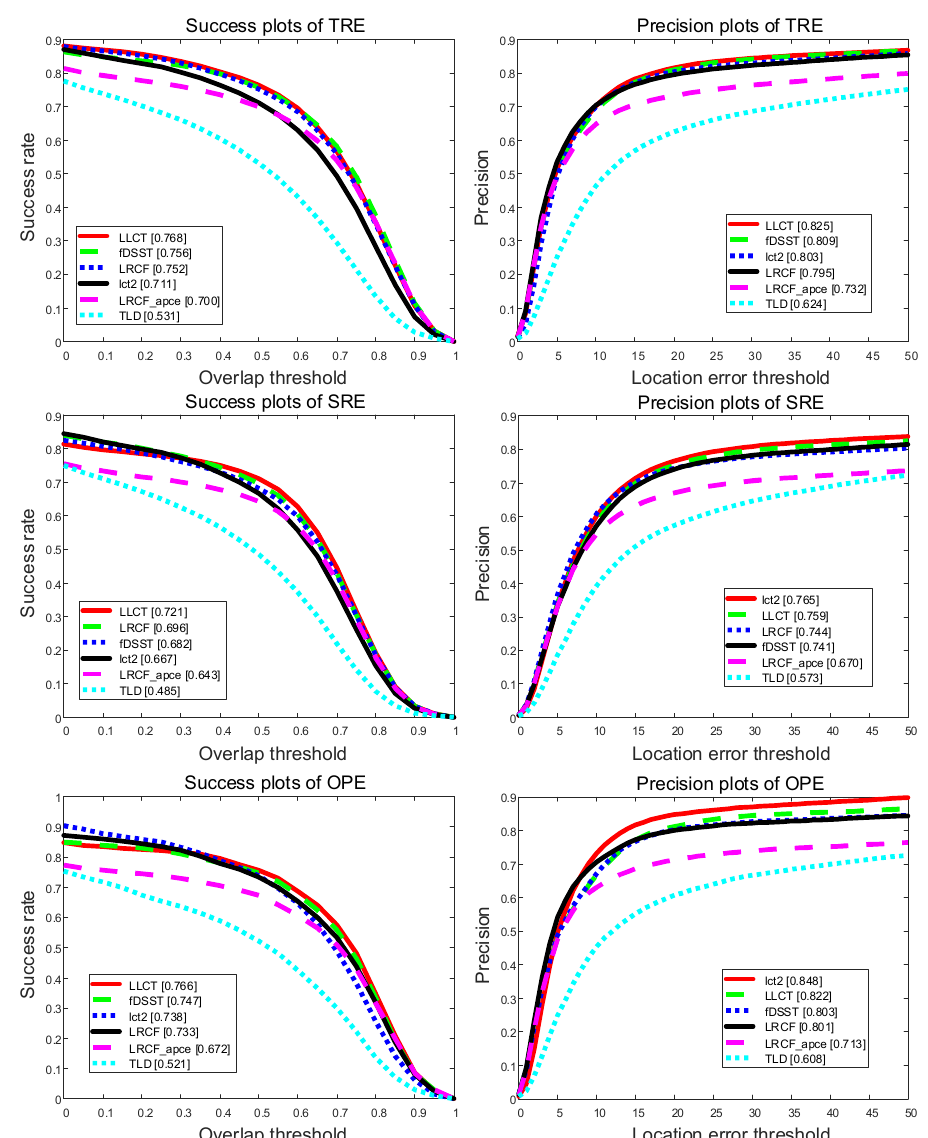
Figure 6. Distance precision and overlap success plots of the average overall performance on the OTB dataset. Temporal robustness evaluation (TRE), spatial robustness evaluation (SRE), and one pass evaluation (OPE) are presented in this figure. For more details, please refer to [1].